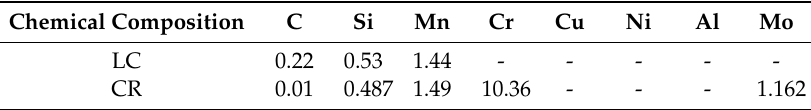
Table 1. Chemical composition of the experimental steel